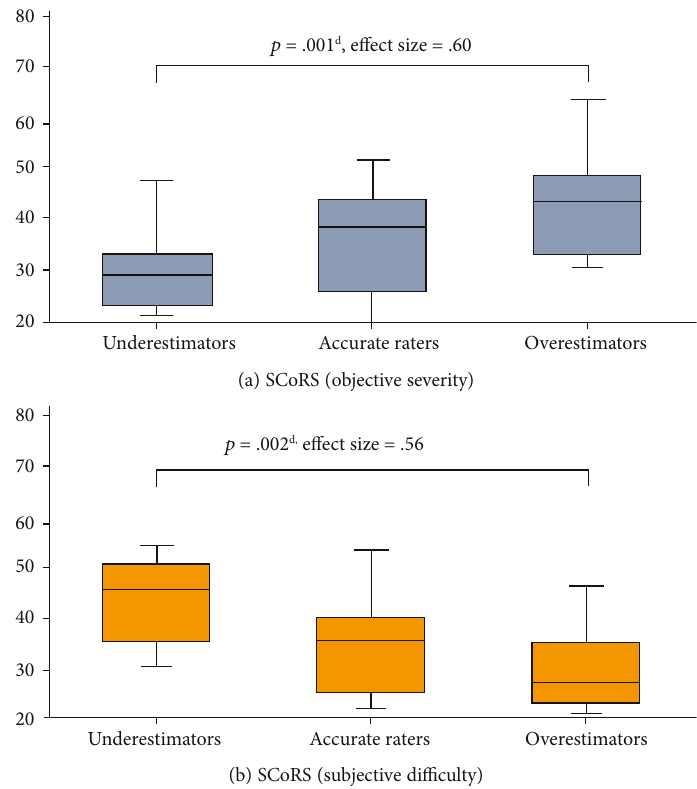
Figure 2: Comparison between objective and subjective ratings of cognitive functioning among the three groups. Note. d Multiple comparisons with Bonferroni correction; SCoRS: the Schizophrenia Cognition Rating